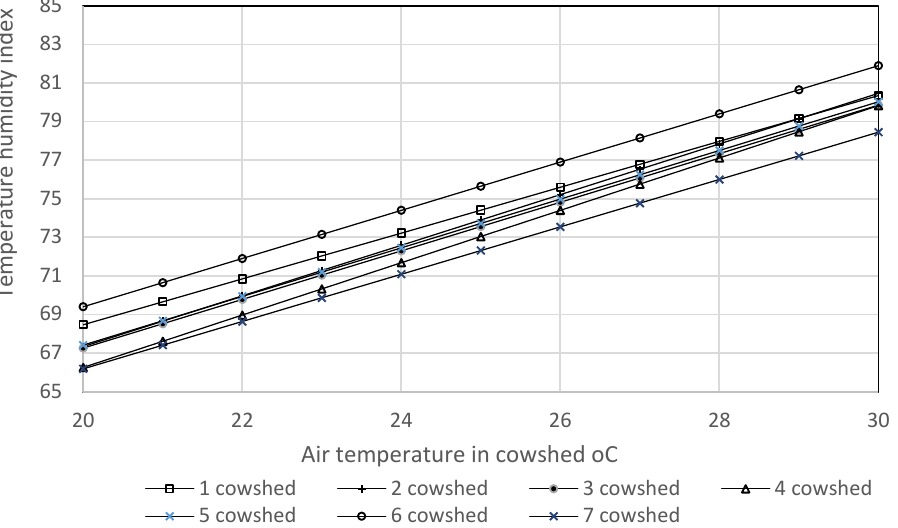
Figure 10. Variation of temperature and humidity index in different cowsheds during the heat period.